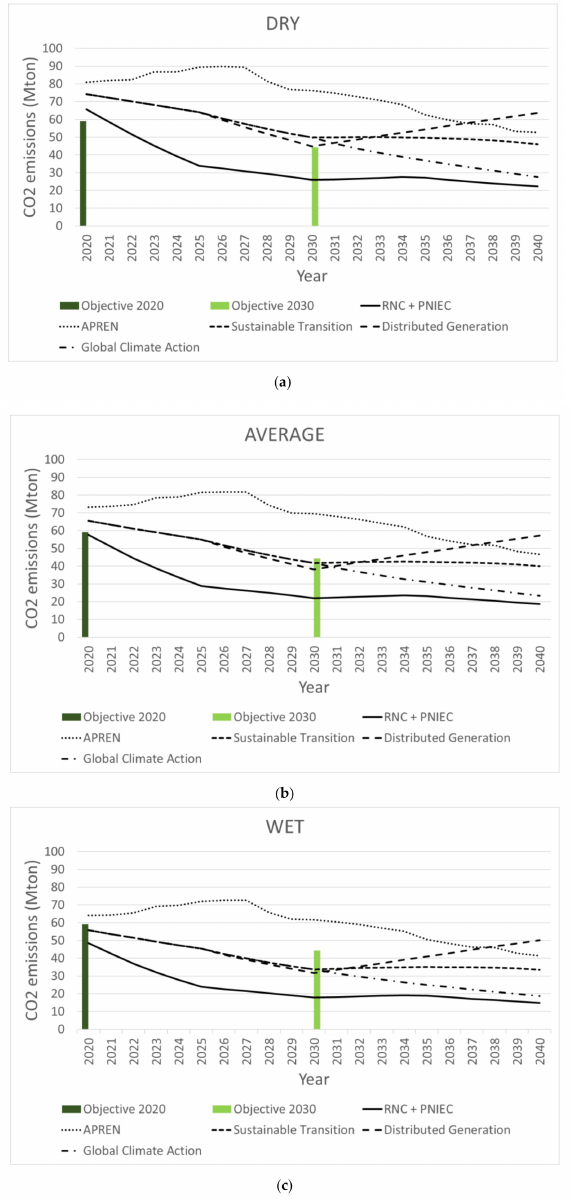
Figure 4. CO 2 emissions and European objectives for different hydro profiles: ( a ) hydro dry profile; ( b ) hydro average profile; ( c ) hydro wet